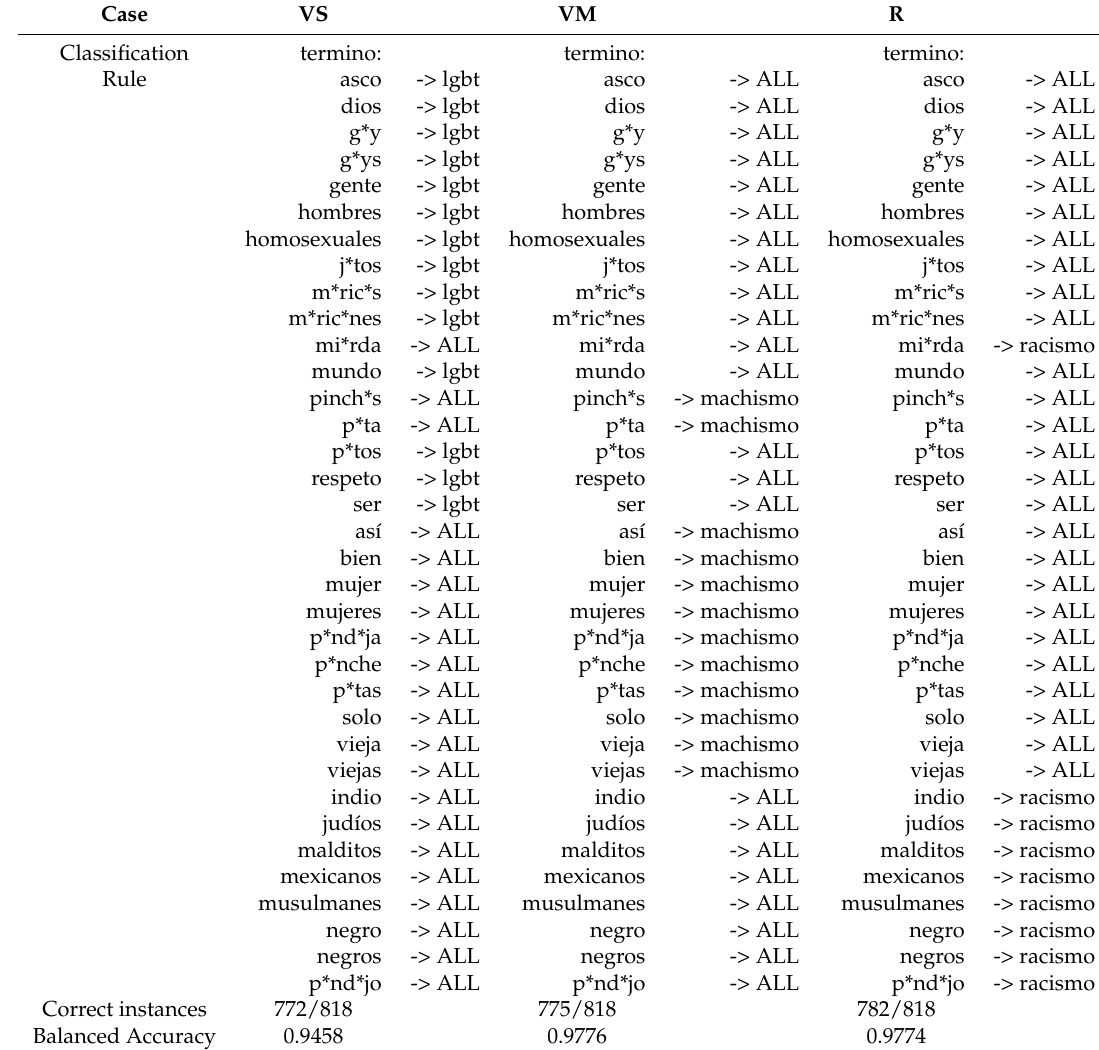
Table 7. Best rule for each aggression